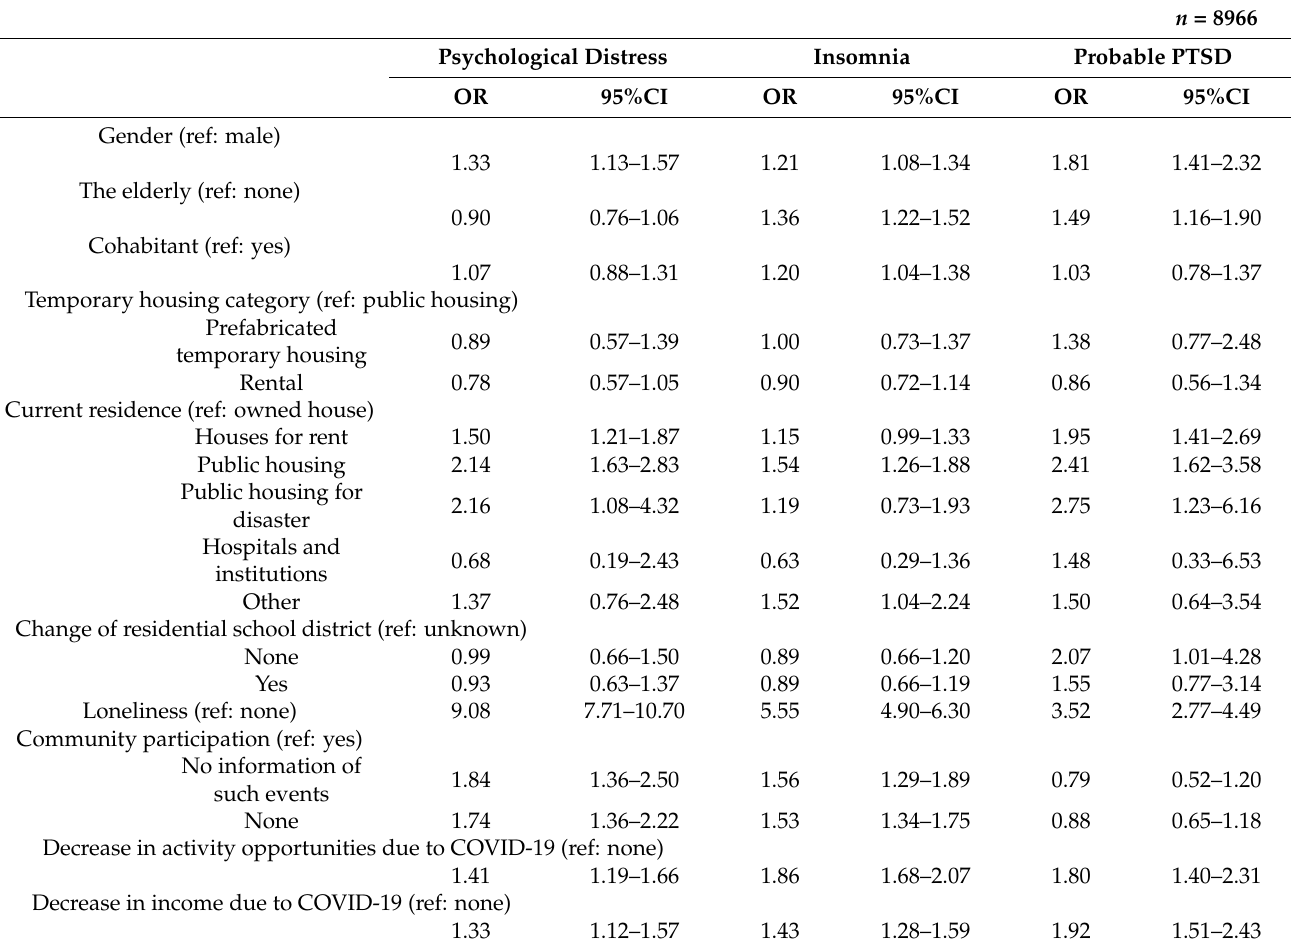
Table 4. Association between the presence of mental health problems and each independent